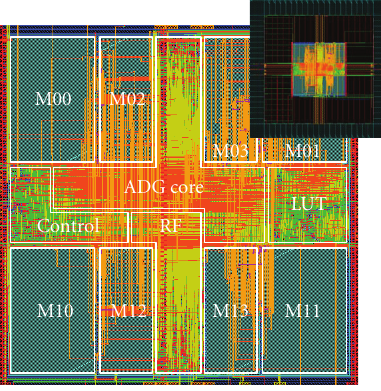
Figure 17: Layout of proposed multimode